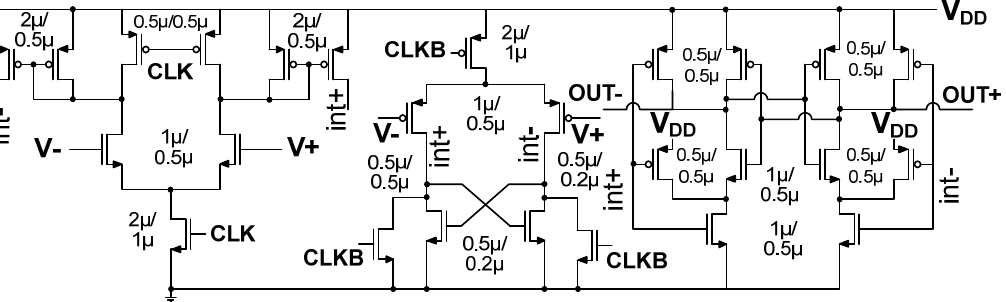
Figure 11. Schematic of the comparator having complementary differential input pairs. V DD = 1.8